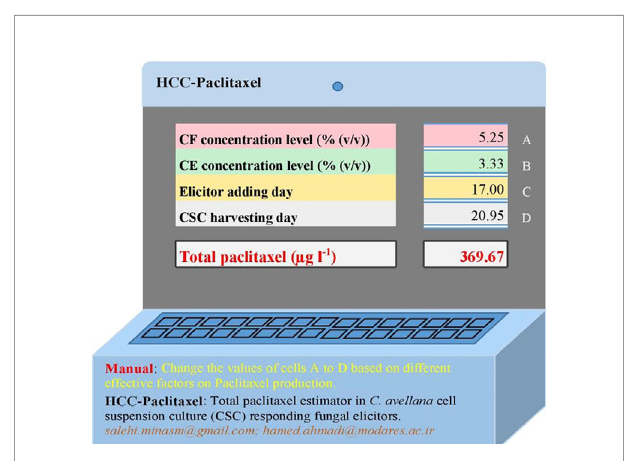
FIGURE 5 | HCC-paclitaxel: an Excel ® estimator for predicting total paclitaxel value in Corylus avellana cell culture responding fungal elicitors using multilayer perceptron-genetic algorithm (MLP-GA) model. CE, cell extract; CF, culture fi ltrate. This estimator was presented as Supplementary